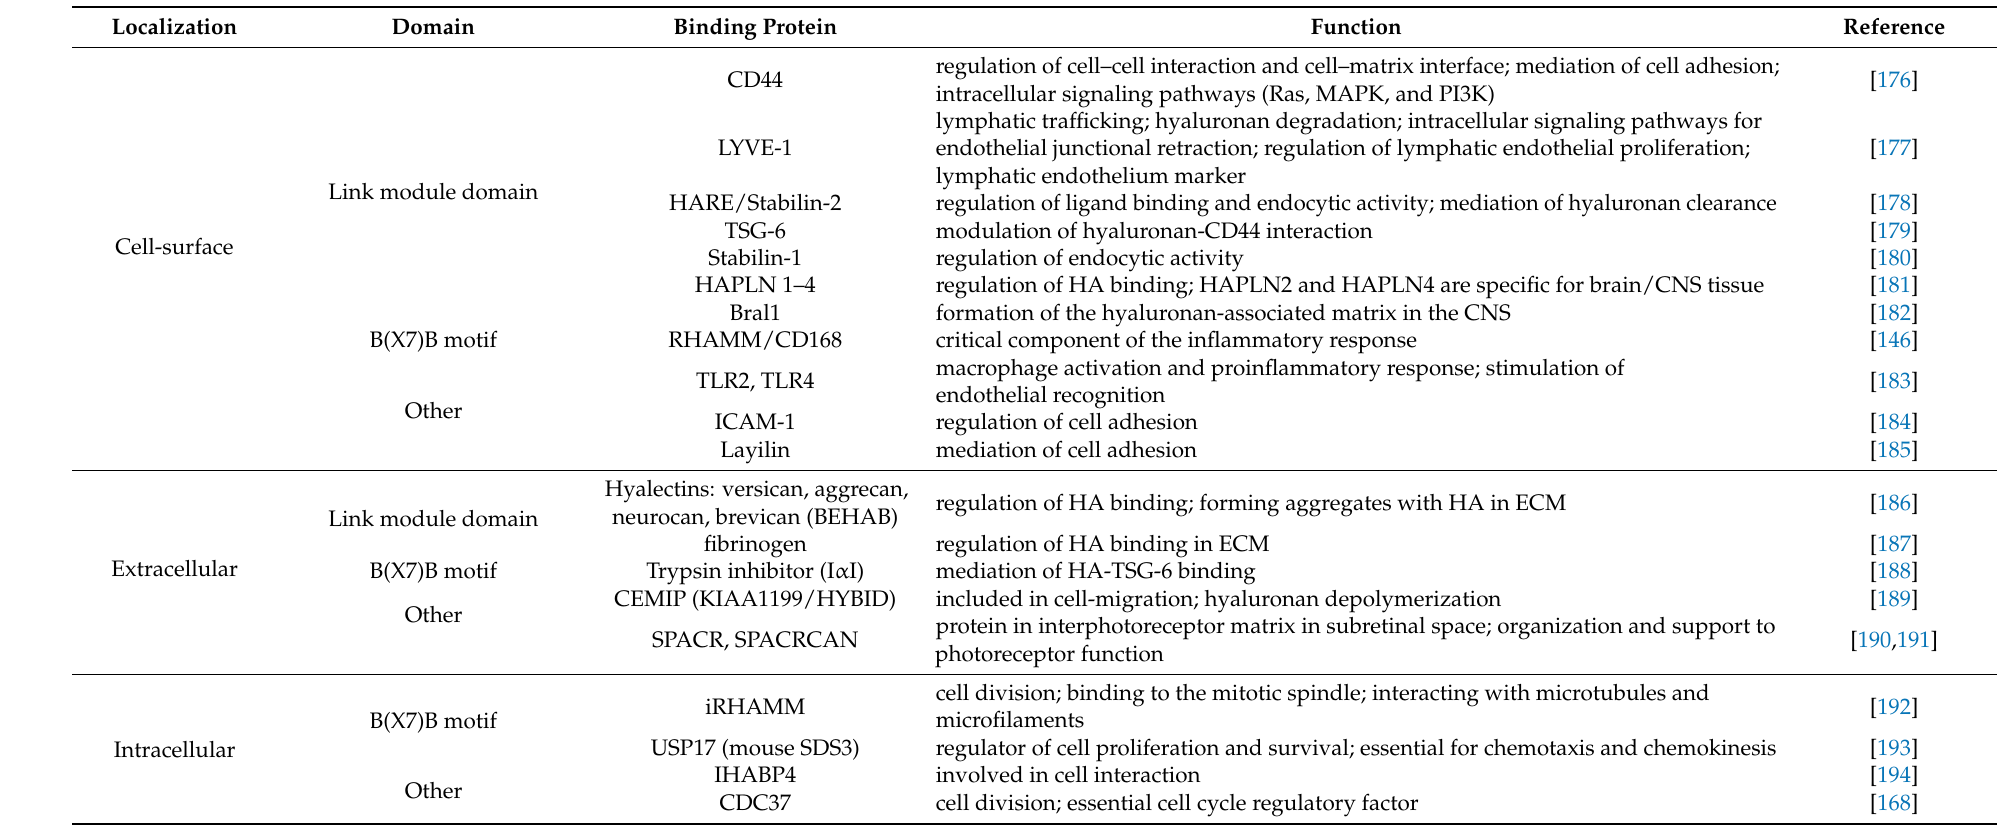
Table 1. Hyaluronan-binding